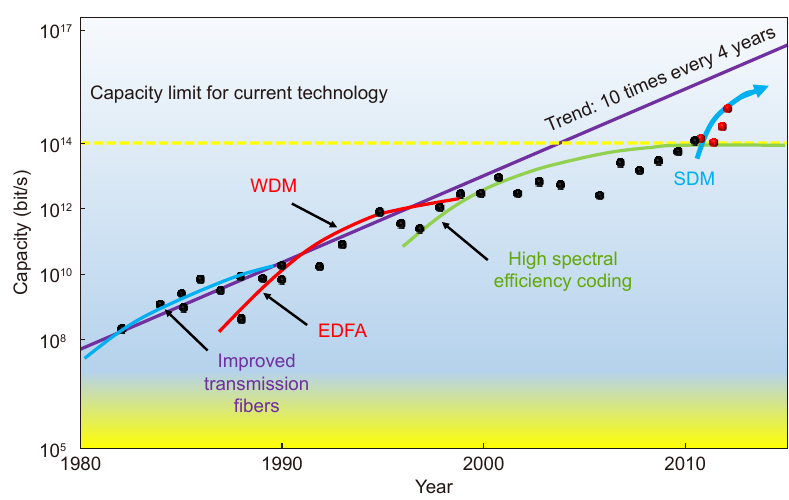
Fig. 2 | The advancement of transmission volume in FOs established by the state-of-the-art